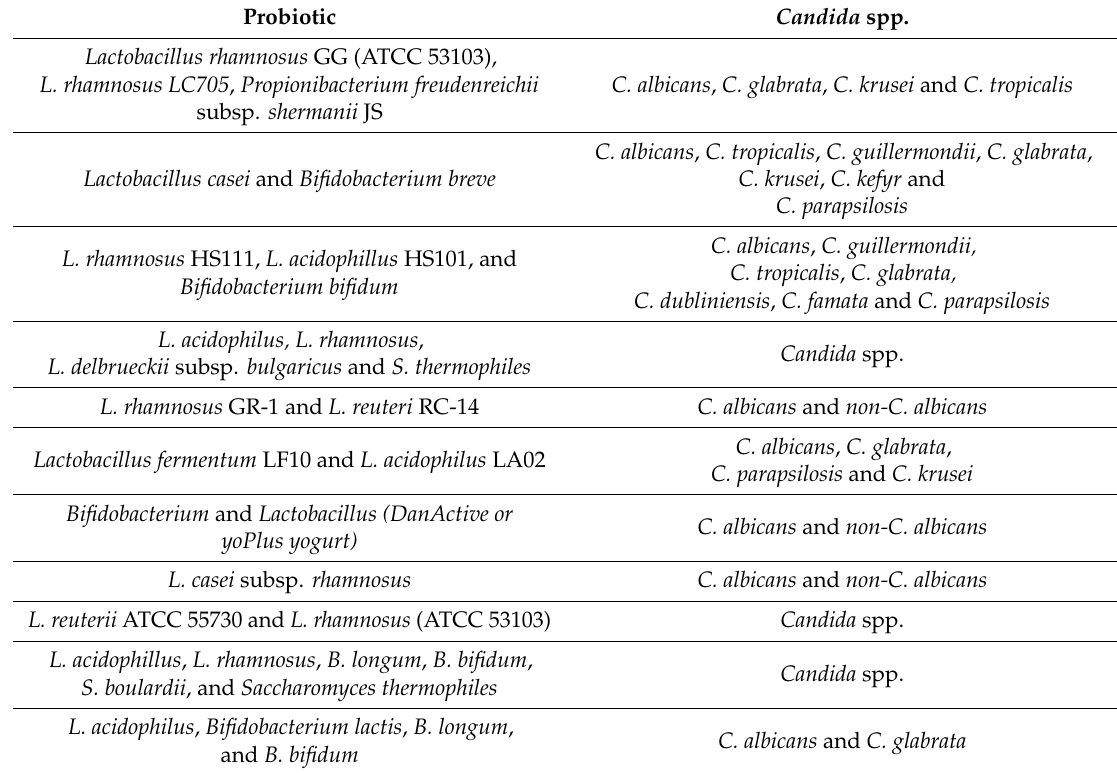
Table 6. List of probiotics and Candida spp. by which these probiotics show antagonistic activity.